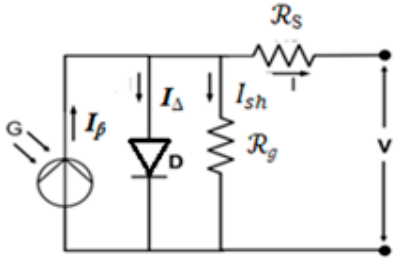
Figure 1. Single ‐ diode PV